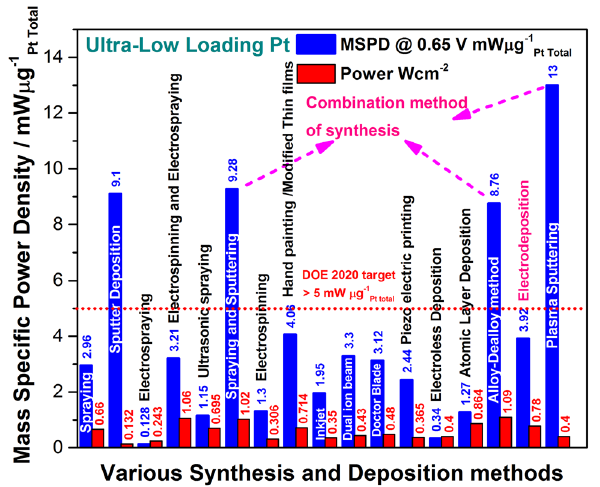
Fig. 4 Ultra-low loading of catalyst (both anode and cathode) by vari- ous synthesis methods and MSPD values compared with DOE 2020